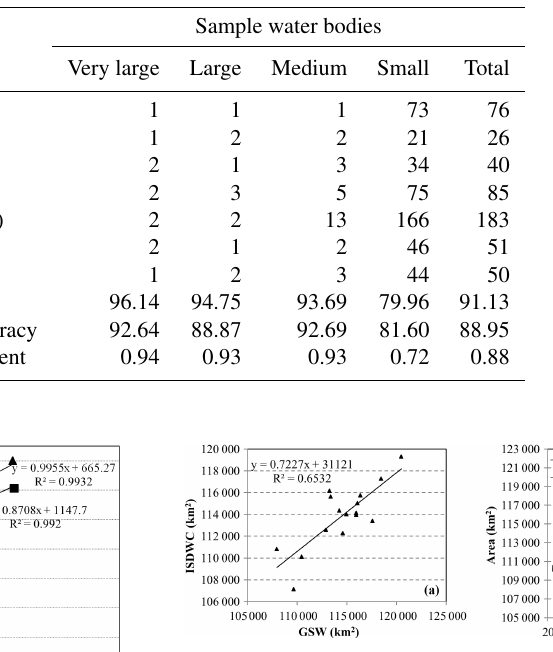
Table 3. Accuracy analysis samples in different regions and the accuracy evaluation results.